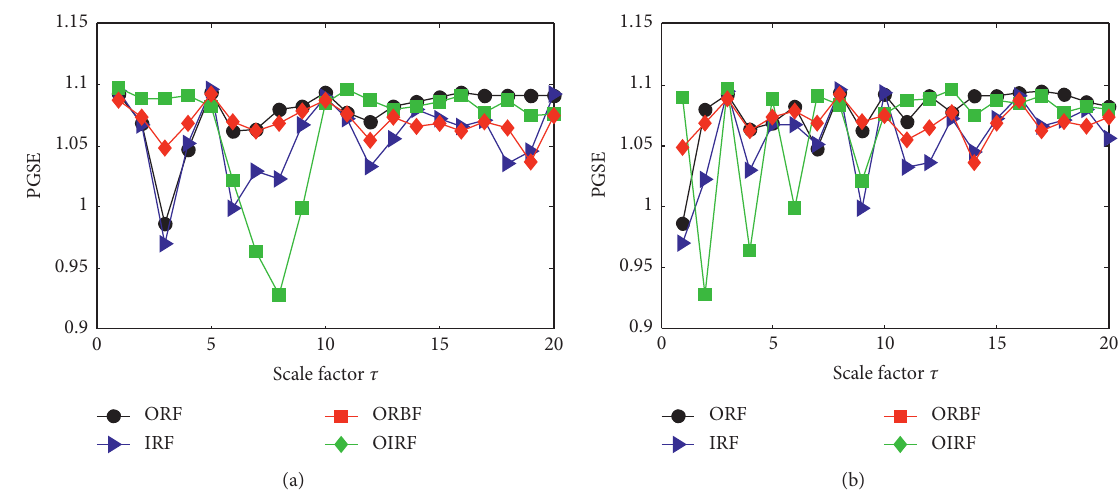
Figure 28: (a) The original distribution of MPGSE and (b) the new distribution of MPGSE after applying the LS method in case 2.